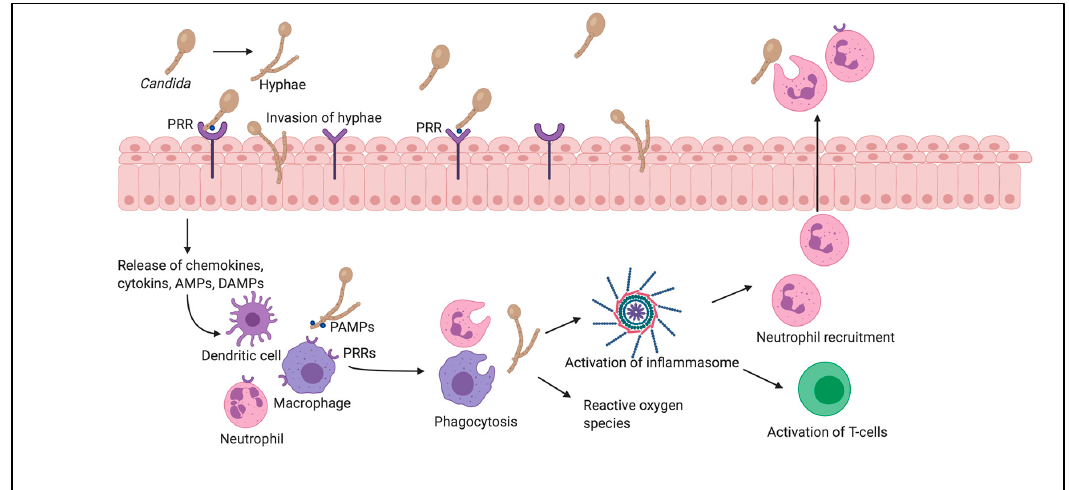
Figure 1. Pathogenesis of vulvovaginal candidosis .